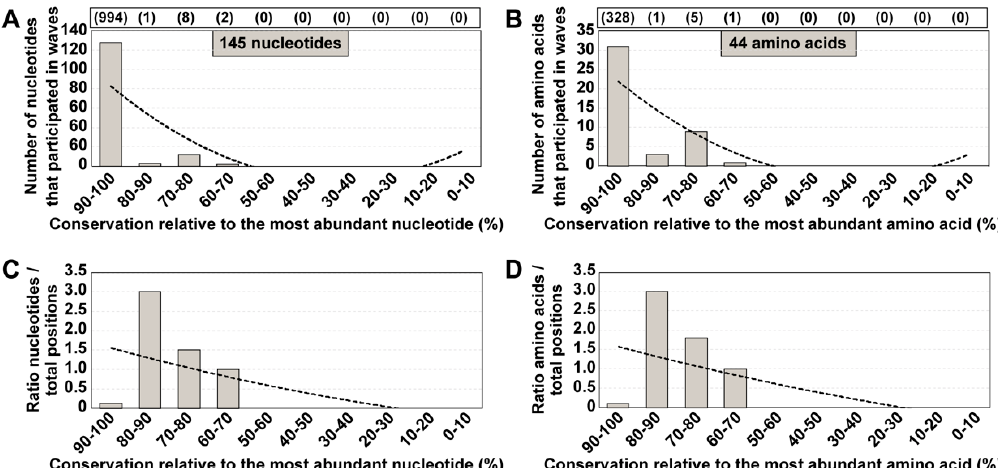
Figure 3. Degree of conservation of those residues that participated in mutational waves. ( A ) Number of nucleotides involved in mutational waves distributed among conservation groups, calculated relative to the most abundant nucleotide at the corresponding position in the alignment of 39 consensus sequences. Conservation groups are indicated in abscissa, and the number of nucleotides that participated in mutational waves in each group is given in ordinate. The total number of nucleotides within residues 7649 to 8653 from the alignment that falls in each conservation category is indicated in parenthesis in the upper box. The discontinuous line corresponds to function y = 2.8636x 2 − 39.009x + 118.8 (R 2 = 0.6221). ( B ) Same as A but at the amino acid level. The discontinuous line corresponds to function y = 0.6818x 2 − 9.6091x + 31 (R 2 = 0.7135). ( C ) Data of A normalized to the number of residues in each conservation group; normalization was performed by dividing the latter number by the total number of residues from the consensus sequence alignment that fell into the corresponding group. The discontinuous line corresponds to function y = 0.0086x 2 − 0.2926x + 1.8409 (R 2 = 0.3595). ( D ) Data of B normalized to the number of residues in each conservation group. The discontinuous line corresponds to function y = 0.0067x 2 − 0.2788x + 1.8651 (R 2 = 0.3577). The position of each mutation and amino acid substitution is given in Table S1.